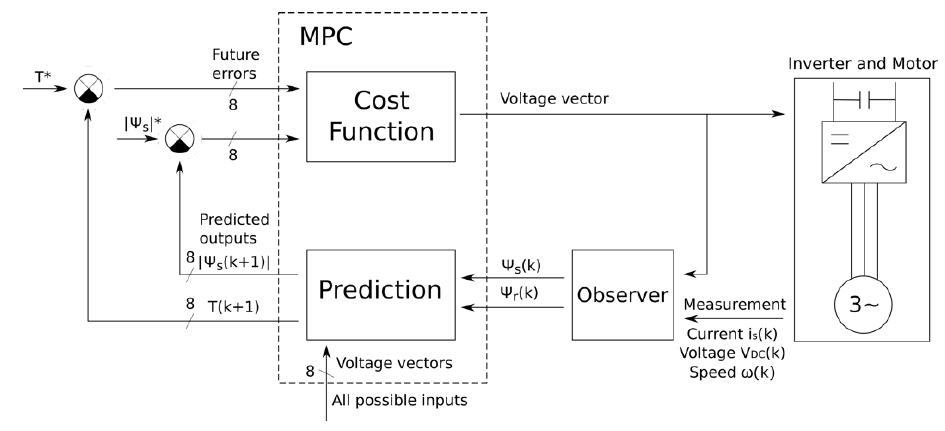
Figure 1. Block diagram of the induction motor drive model predictive control.